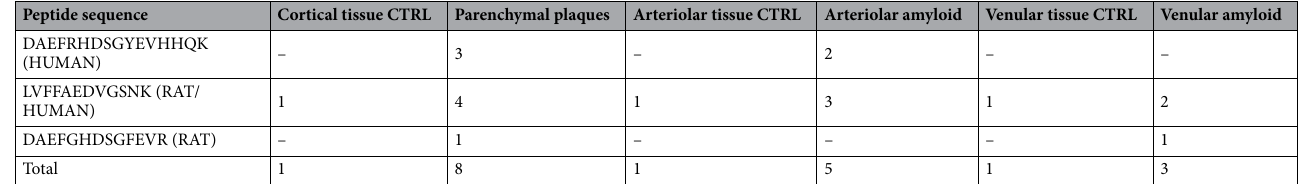
Table 1. Total spectrum counts of the Aβ peptide in parenchymal plaques, arteriolar and venular amyloid